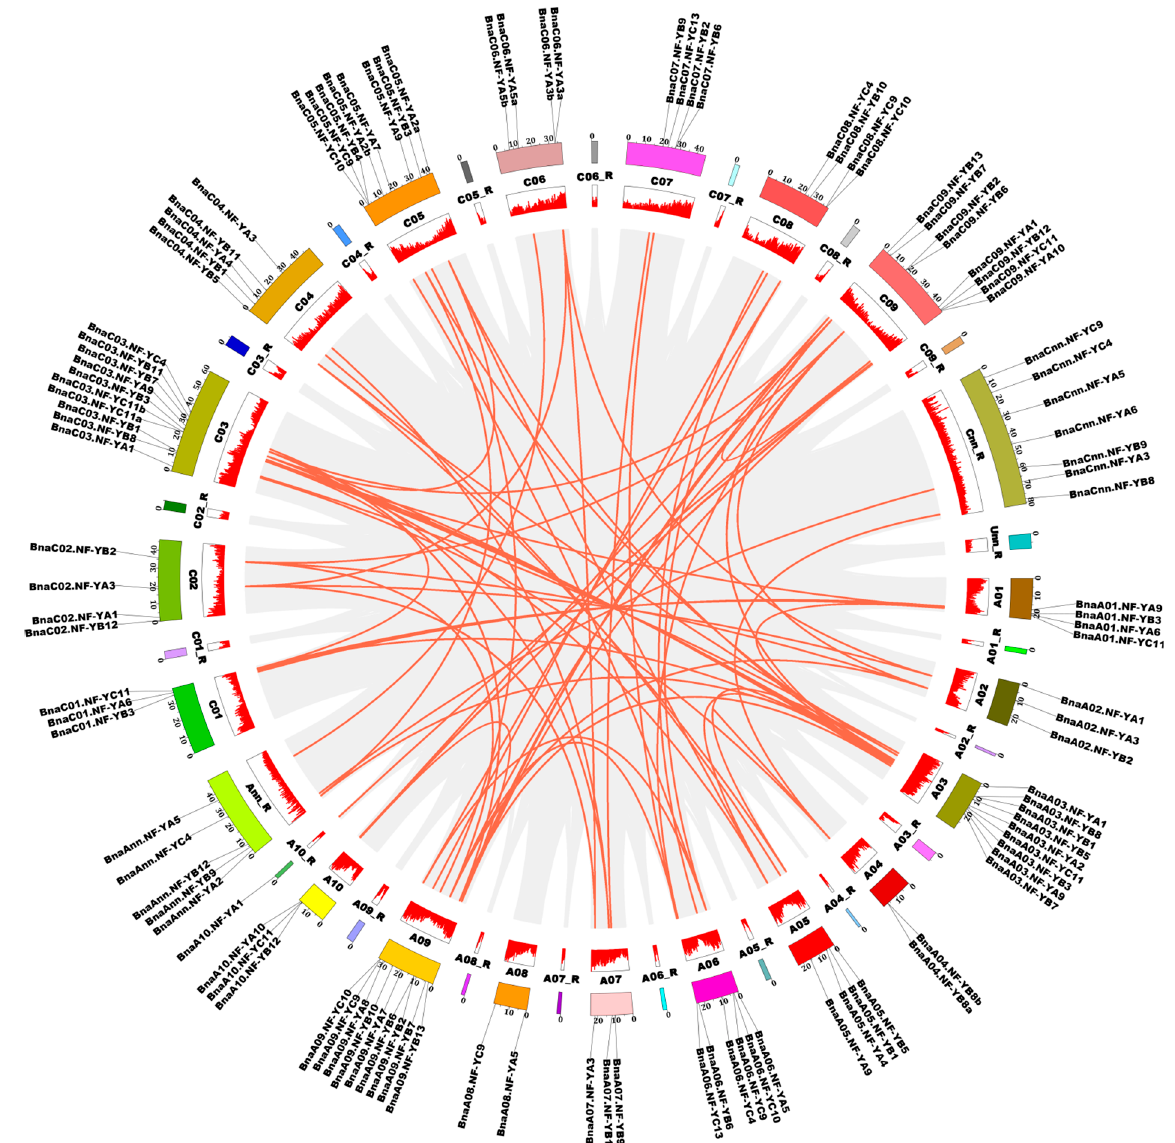
Figure 5. Schematic representations for the chromosomal distribution and interchromosomal relationships of the rapeseed NF-Y genes. The chromosomal localizations are shown in the outer cycle. The sequence length of each B. napus chromosome is indicated by the numbers along the box. The BnaNF-Y genes are mapped on the different chromosomes. Gene density of the whole B. napus genome is shown in the inner cycle. The higher the red column in the inner circle, the more genes there are on the chromosome. Gray lines inside the cycle indicate the genome-wide collinearity within the B. napus genome, while the red lines show the syntenic BnaNF-Y gene pairs. R: random.